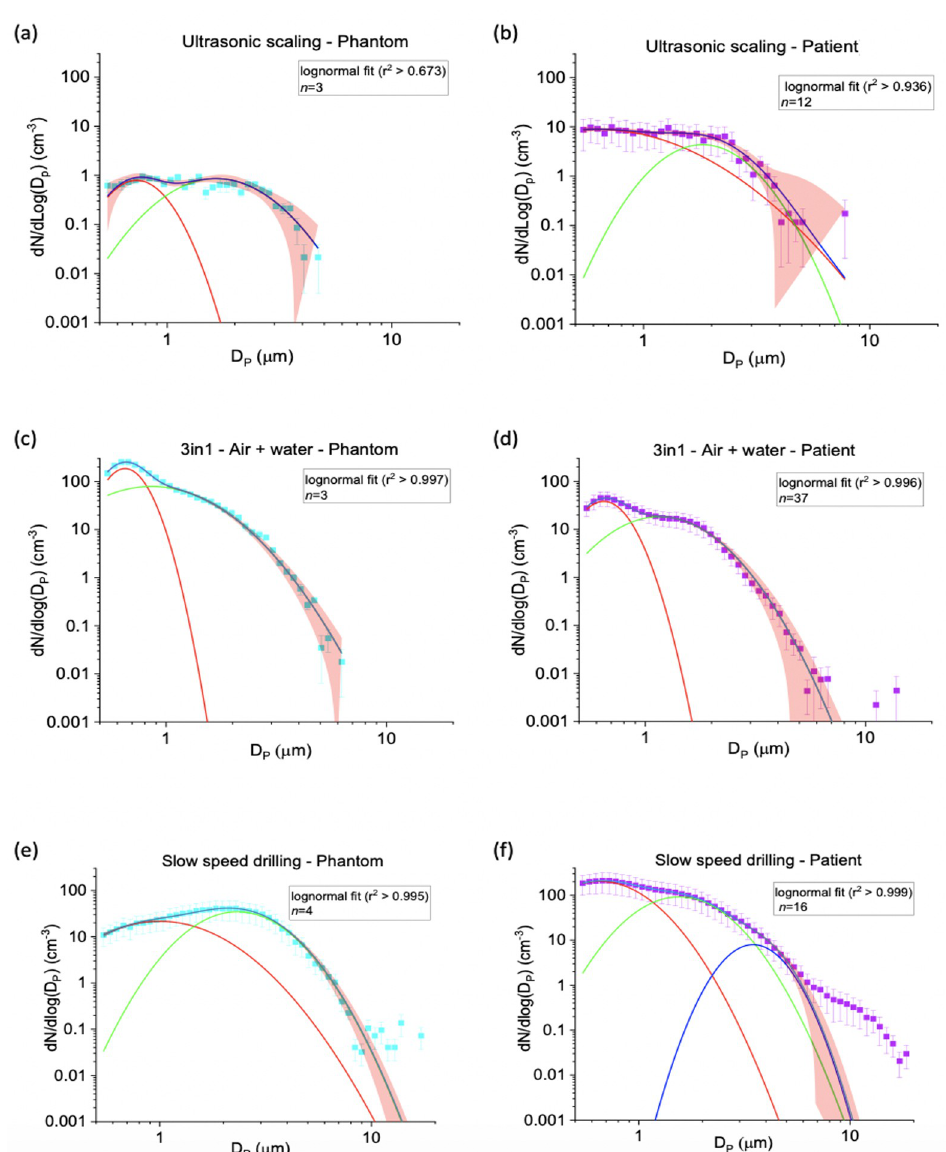
Fig 3. Size distribution data for ultrasonic scaling (a, b), 3-in-1 (c, d) and slow-speed drilling (e, f). Mode 1 (red line), mode 2 (green line), mode 3 (dark blue line) and cumulative bi- or tri-modal fit (blue line). 95% confidence band is shown as the red shaded area, n = number of procedures and error bars represent ( ± standard